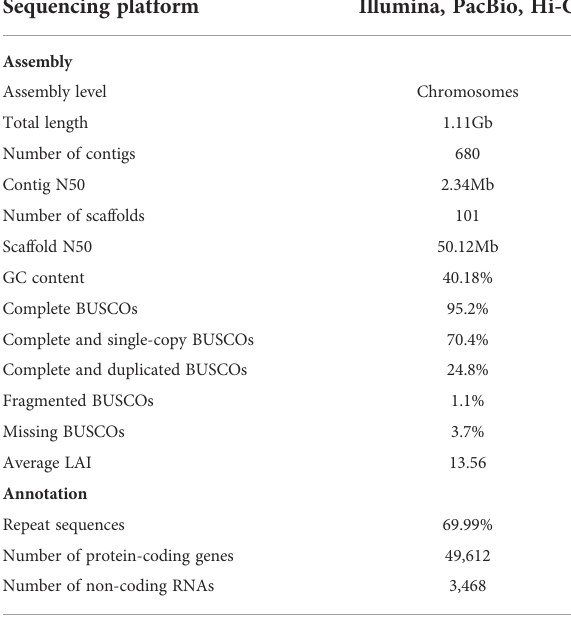
TABLE 1 The major characteristics of C. longa (2n=3x=63) genome. Sequencing